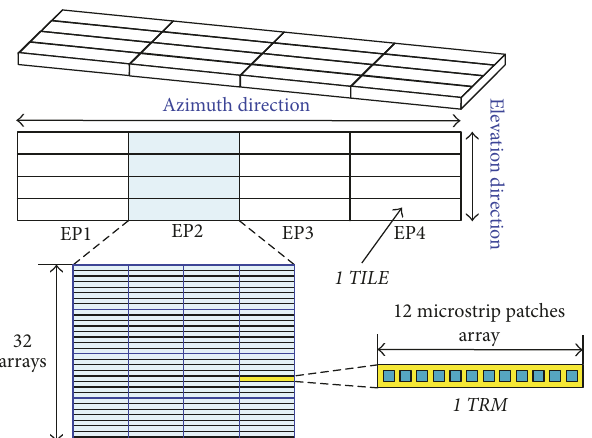
Figure 8: Example of the SAR antenna configuration.